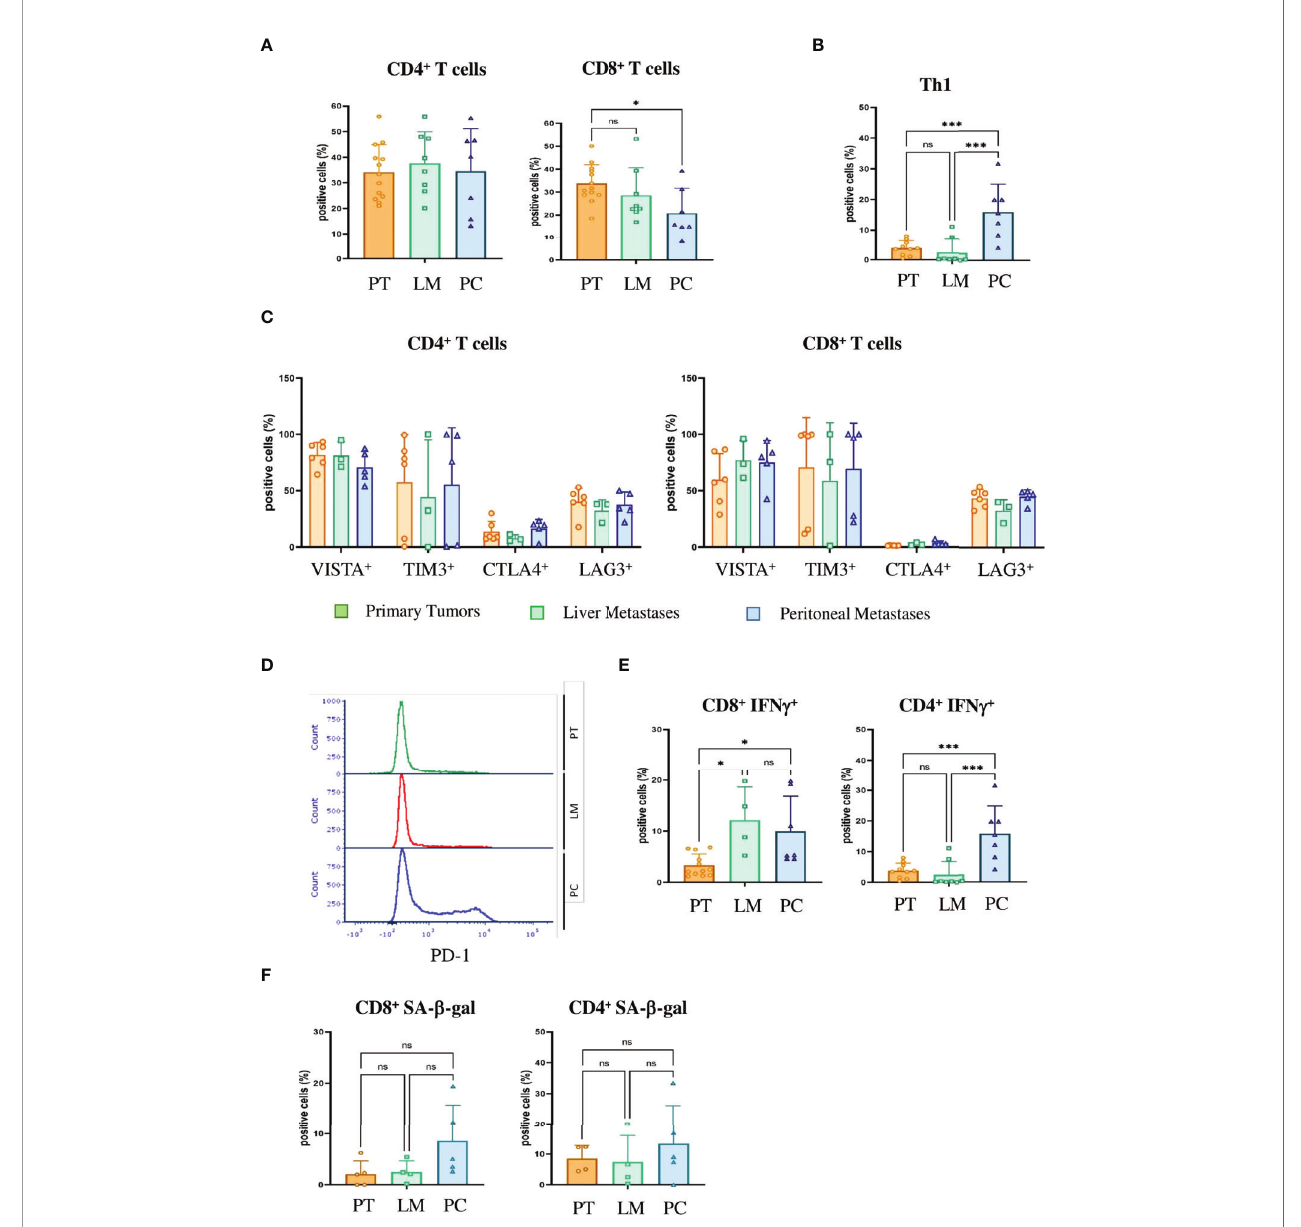
FIGURE 5 | Tumor-in fi ltrating T cells in PC express checkpoint inhibitor molecules, IFN- g and markers of senescence and thus are immunosenescent (A) Flow cytometric analysis of the tumor in fi ltrating lymphocytes of primary tumors (PT), liver metastases (LM) and PC of the orthotopic organoid transplantation CRC mouse model for CD4 + and CD8 + T cells. Dotplots show the percentage of CD4 + and CD8 + T cells gated on CD3 + T cells (n = 13 for PT, n = 8 for LM, n = 7 for PC). (B) The number of IFN- g secreting T helper 1 (Th1) cells evaluated by FACS in the tumor microenvironment of primary tumors (PT), liver metastases (LM) and PC of the orthotopic organoid transplantation CRC mouse model. Dotplots show the percentage of IFN- g secreting CD4 + T cells gated on live CD45 + CD3 + T cells (n = 13 for PT, n = 8 for LM, n = 7 for PC). (C) Flow cytometric analysis of CD4 + (left panel) and CD8 + (right panel) T cells for checkpoint molecules VISTA, Tim3, CTLA4 and Lag3 in tumor in fi ltrating lymphocytes of primary tumors (PT), liver metastases (LM) and PC of the orthotopic organoid transplantation CRC mouse model. Dotplots show the percentage of the CD4 + and CD8 + T cells expressing the respective immune checkpoint molecule (n = 8 for PT, n = 3 for LM, n = 4 for PC). (D) Flow cytometric analysis of the expression of PD1 on tumor-in fi ltrating CD8 + T cells from primary tumors (PT), liver metastases (LM) and PC of the orthotopic organoid transplantation CRC mouse model. (E) Flow cytometric analysis from tumor-in fi ltrating CD8 + and CD4 + T cells for IFN- g secretion of primary tumors (PT), liver metastases (LM) and PC of the orthotopic organoid transplantation CRC mouse model. Dotplots show the percentage of IFN- g positive CD4 + and CD8 + T cells (n = 12 for PT, n = 4 for LM, n = 7 for PC). (F) Flow cytometric analysis of SA- b -gal positive tumor-in fi ltrating CD8 + and CD4 + T cells in the tumor microenvironment of primary tumors (PT), liver metastases (LM) and PC of the orthotopic organoid transplantation CRC mouse model. Dotplots show the percentage of SA- b -gal CD4 + and CD8 + T cells (n = 5 for PT, n = 4 for LM, n = 5 for PC). Error bars represent the mean ± SD. One-way ANOVA (A – C, E, F) ***p < 0.0002, *p<0.05, n.s. = not signi fi cant. In all analysis Zombie NIR staining was used to discriminate dead from live cells and only live Zombie-negative cells were quanti fi